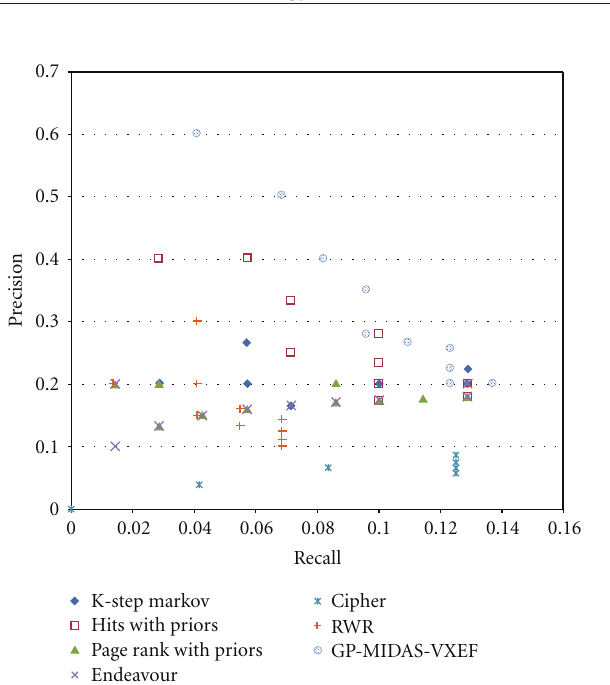
Figure 3: ROC curves comparing the performance of GP-MIDAS- VXEF with existent state-of-the-art network-based prioritization